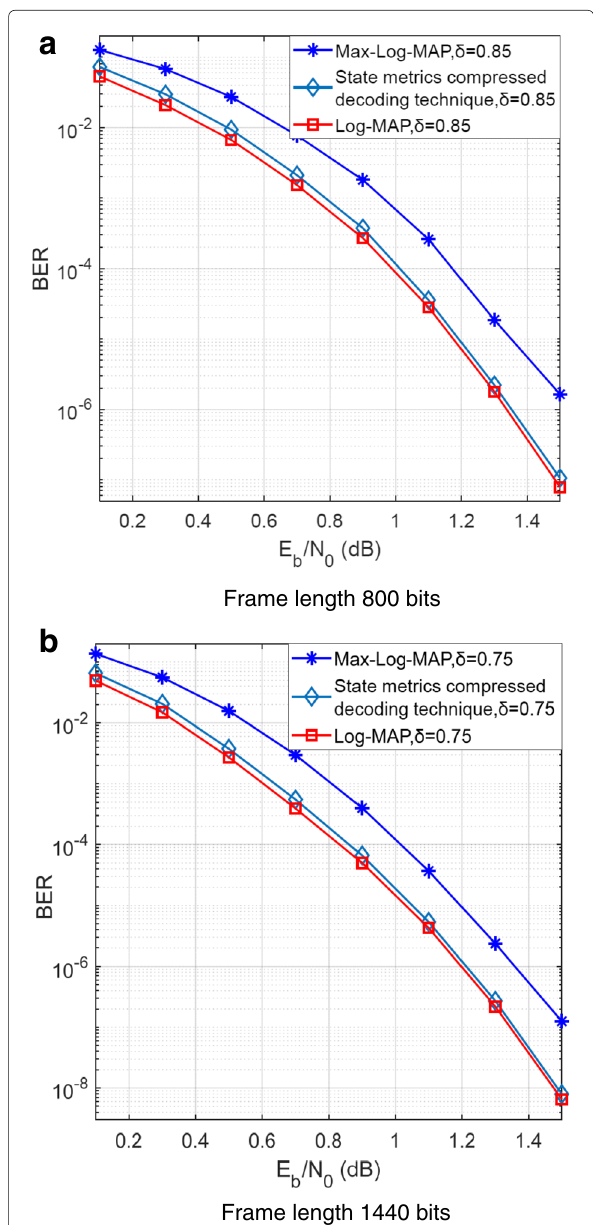
Fig. 6 BER performance